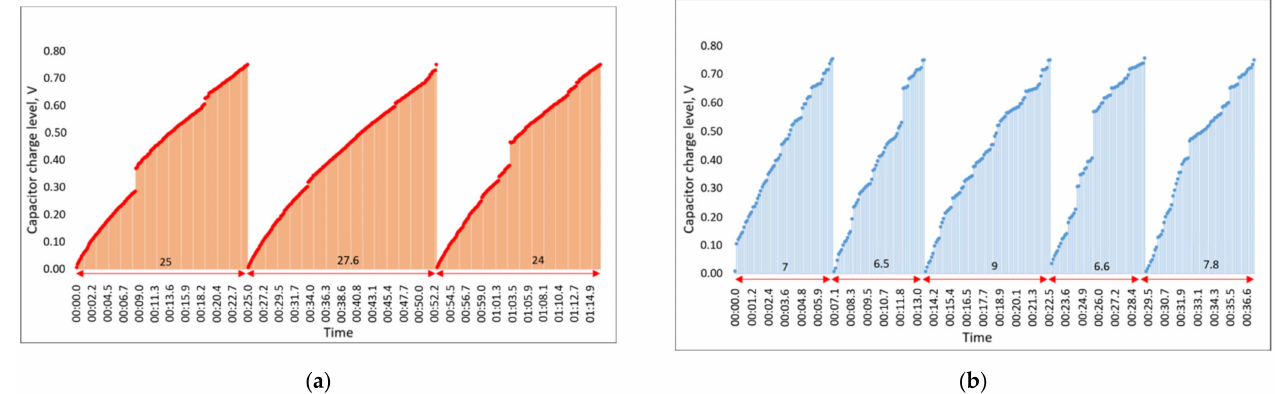
Figure 15. Experimental results of capacitor C4 charging times when tool holder without ( a ) and with ( b ) slots is used during milling